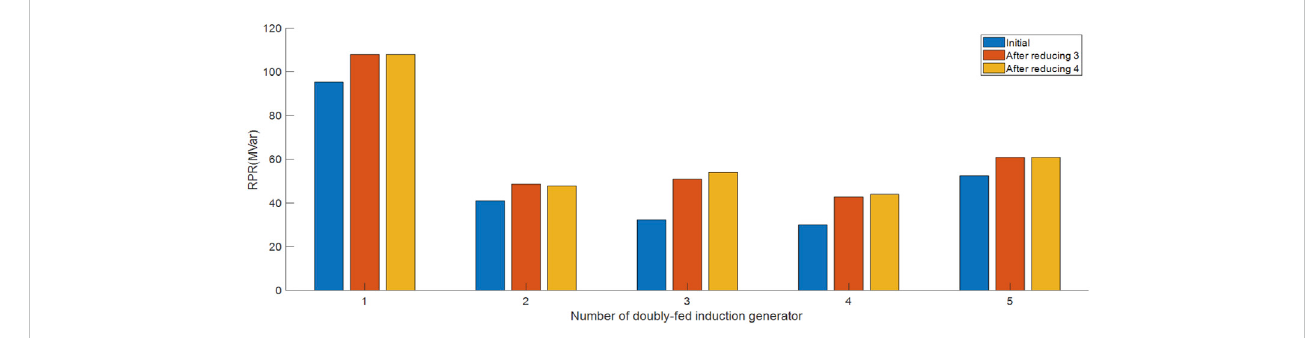
FIGURE 8 The effect of power generation reduction on RPR.